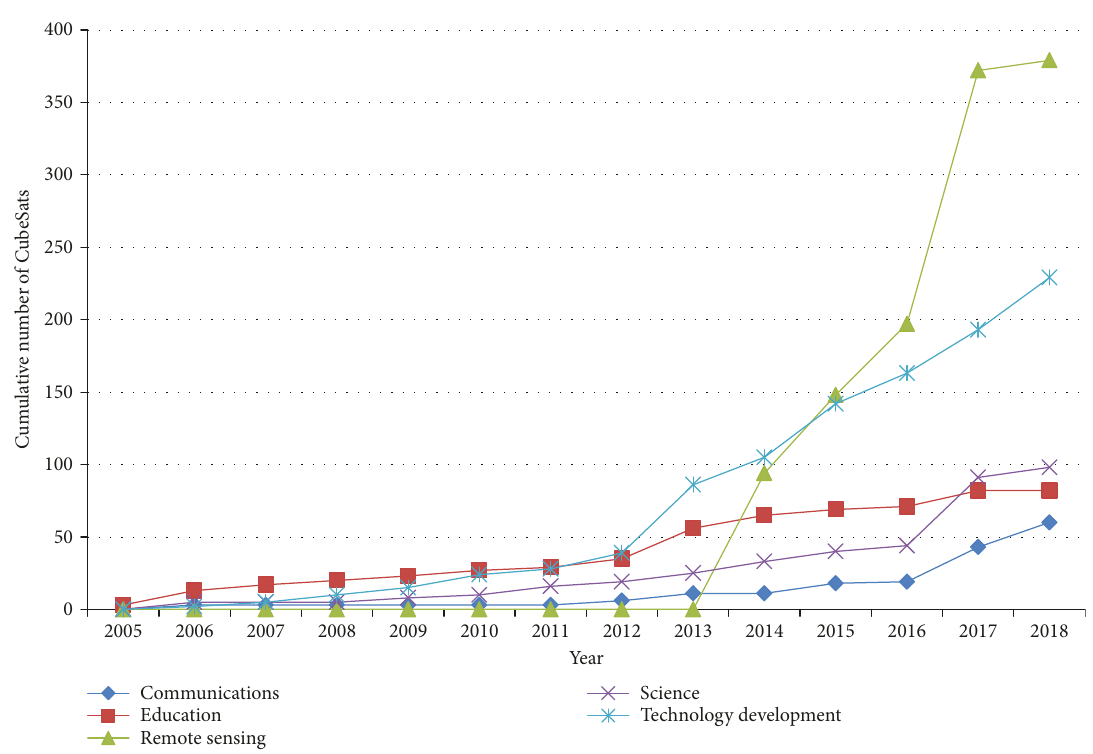
Figure 4: Cumulative number of CubeSats launched per year and per end use from 2005 until May 31,